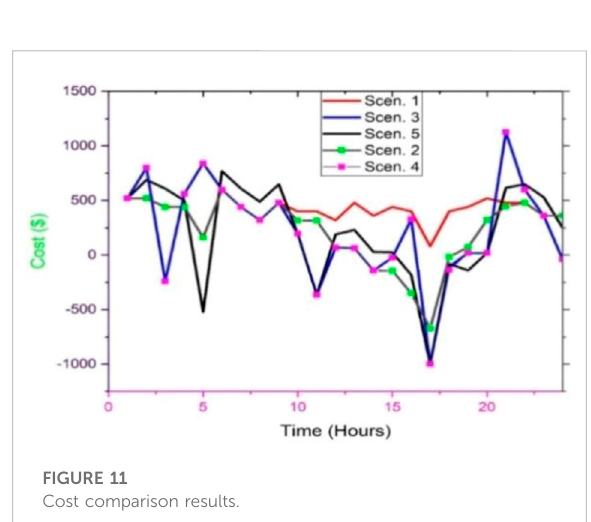
FIGURE 9 Optimal scheduling result without EV.